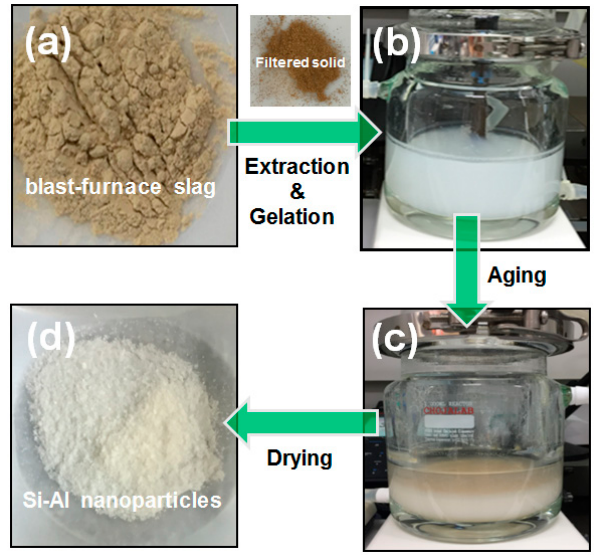
Figure 4. Photographic images depicting the synthesis of the silica-alumina nanoparticles: ( a ) blast-furnace slag; ( b ) gel-rich solution after extracting; ( c ) solution after aging; and ( d ) nanoparticles after drying.